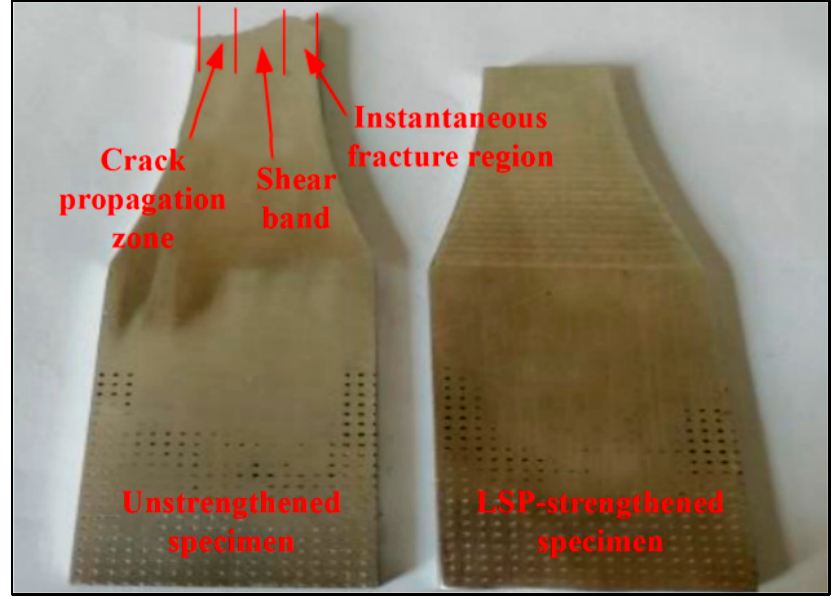
Figure 8. Morphology of the 7B04 aluminum alloy specimen after the fatigue test.